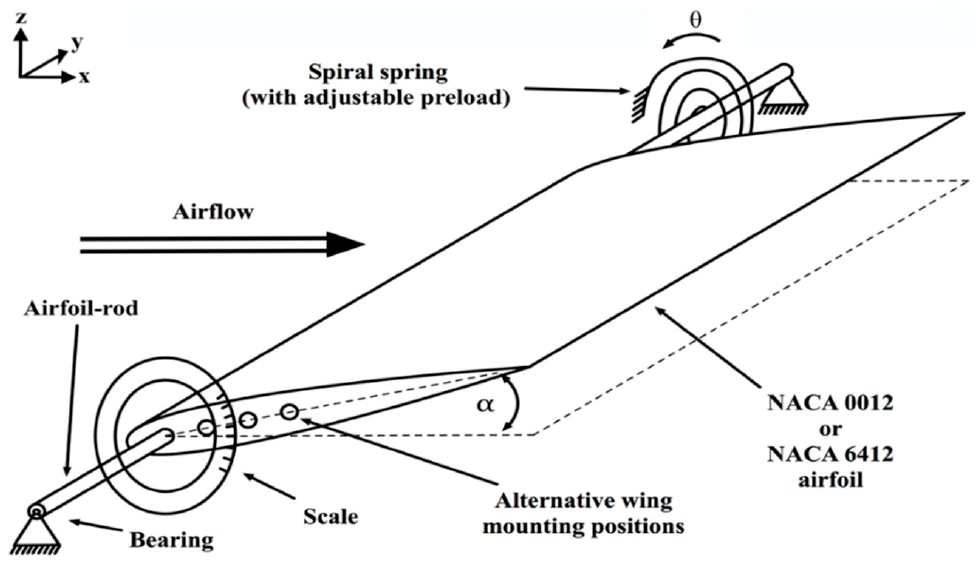
Figure 1. Schematic of the aeroelastic system.